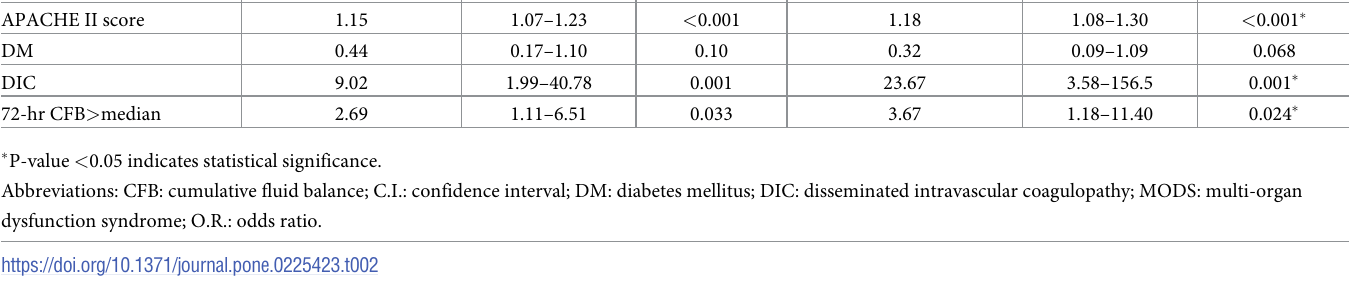
The mean duration of ICU stays and hospital stays were 15.6 ± 14.0 days and 40.3 ± 33.0 days, respectively. Patients who developed MODS had a similar mean ICU stay (15.9 ± 14.0 vs. 14.9 ± 14.4 days, p = 0.73) and hospital stay (41.4 ± 33.2 vs. 37.7 ± 33.0 days, p = 0.59), compared to those without MODS. The duration of ventilator use (15.5 ± 16.4 vs. 13.2 ± 15.3 days, p = 0.592